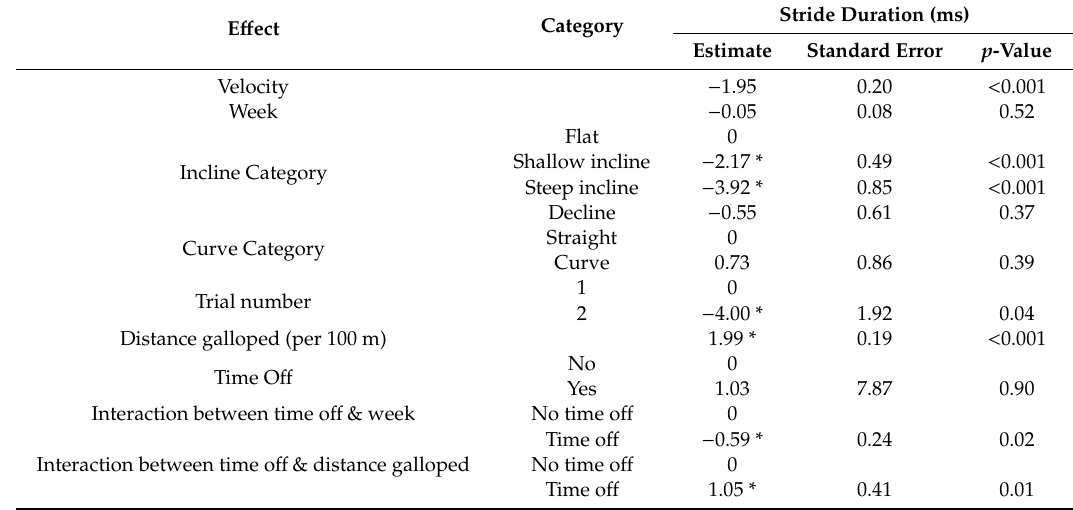
Table 2. Final multivariable model for fixed e ff ects on stride duration (ms) for three-year-old horses. Data were 21,072 strides from 115 separate gallop trials from 24 horses over 34 weeks. Reference categories for incline and curve are flat and straight respectively, and the reference category for time o ff is no time o ff . Week * week indicates the quadratic factor. Stride Duration E ff ect Category